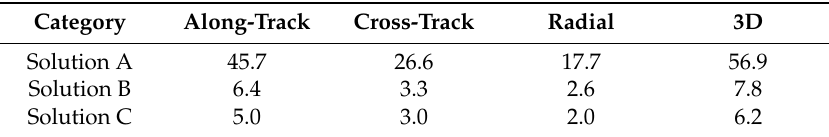
Table 3. Average daily RMS of orbit differences in along-track, cross-track, radial, and 3D with three strategies for FY-3C POD using only BDS (unit: cm).